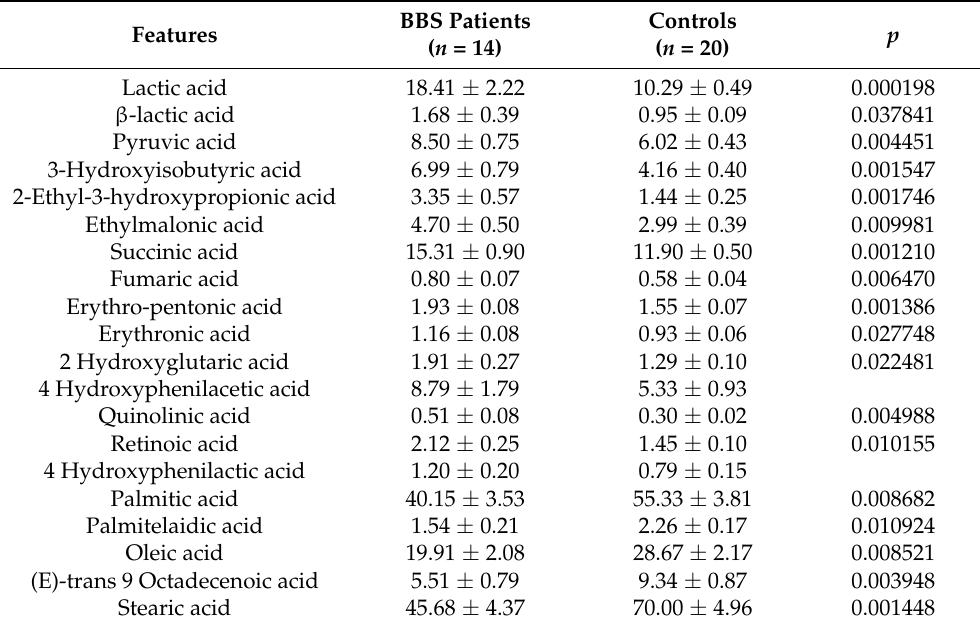
Table 2. Urine concentrations ( µ M) of metabolites differentially represented in BBS patients vs. controls in the pilot study.